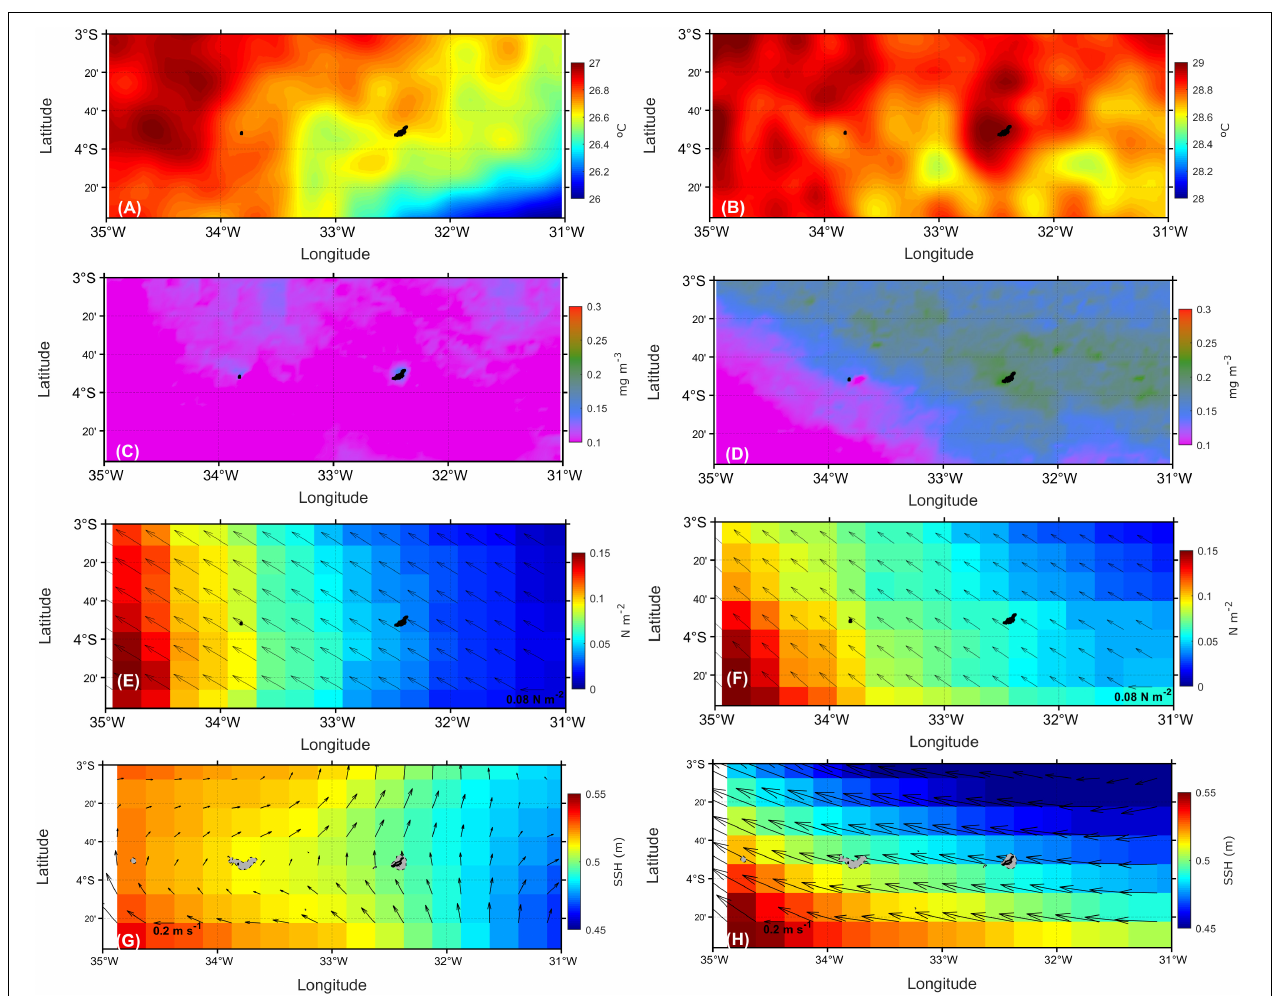
FIGURE 10 | Sea surface temperature in ◦ C (A,B) , Sea surface Chl-a concentration in mg m − 3 (C,D) , wind velocity in m s − 1 (arrows in E,F ), wind stress in N m − 2 (colors in E,F ), surface geostrophic velocities in m s − 1 (arrows in G,H ) and sea surface height (colors in G,H ) in the southwestern tropical Atlantic region (3 ◦ S-4.5 ◦ S, 35 ◦ W-31 ◦ ), for the time periods of ABRACOS cruises in spring 2015 (left side panels) and fall 2017 (right side